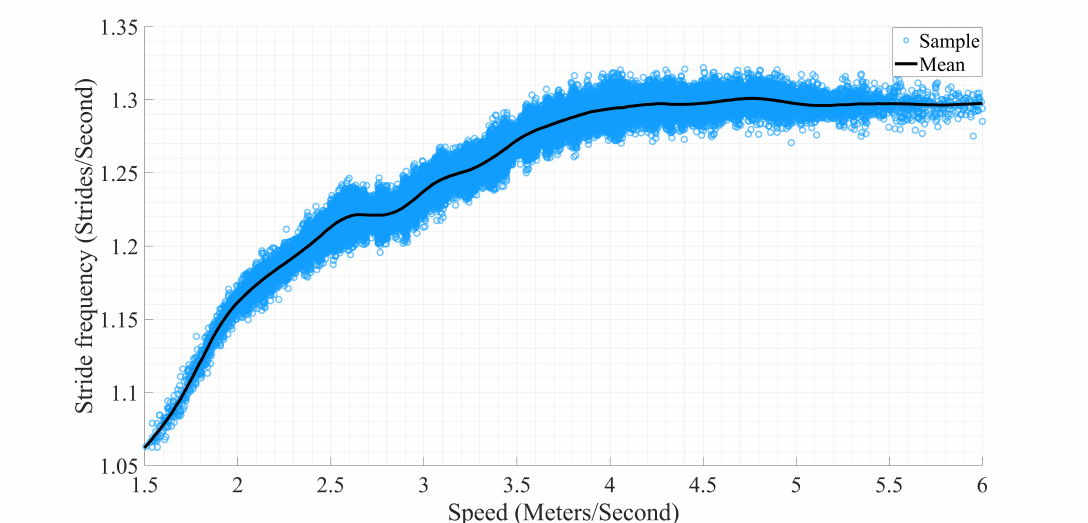
Figure 4. Stride frequency versus